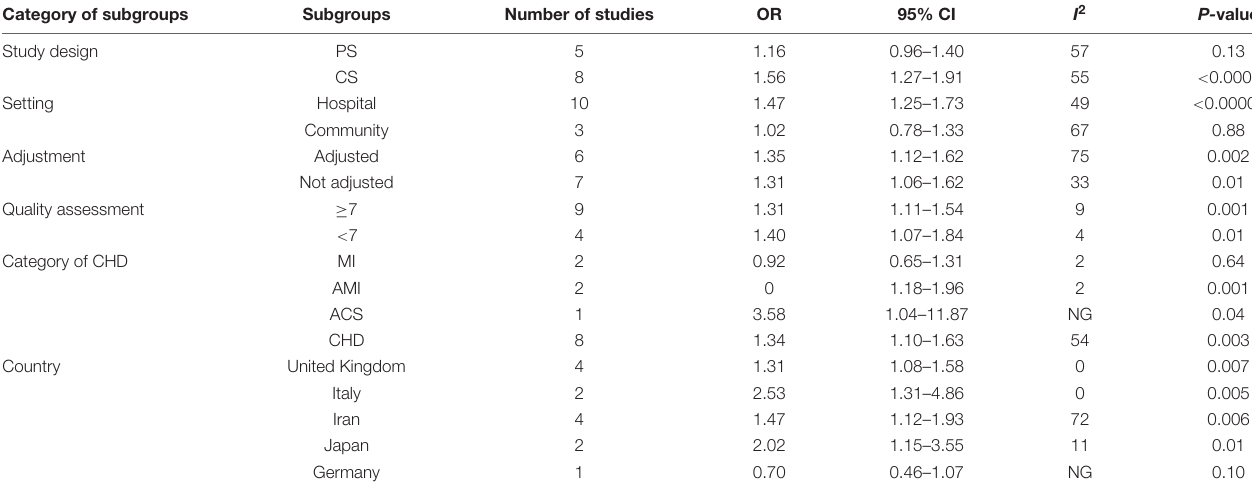
TABLE 3 | Subgroup analyses about between anti-CagA test and CHD.